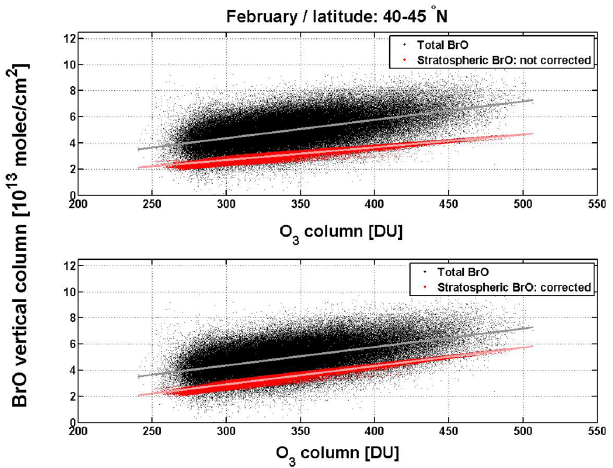
Fig. 3. Illustration of the adjustment procedure used to bring the stratospheric BrO climatology in close agreement with GOME-2 measurements for the Northern Hemisphere (February (40–45 ◦ N)). After adjustment, the slope of the regression line between the strato- spheric BrO VCDs and the O 3 VCDs (light red line) is equal to the slope of the regression line through the scatterplot between the measured total BrO VCDs and the O 3 VCDs (grey line). Note that the total BrO columns are calculated using stratospheric air mass